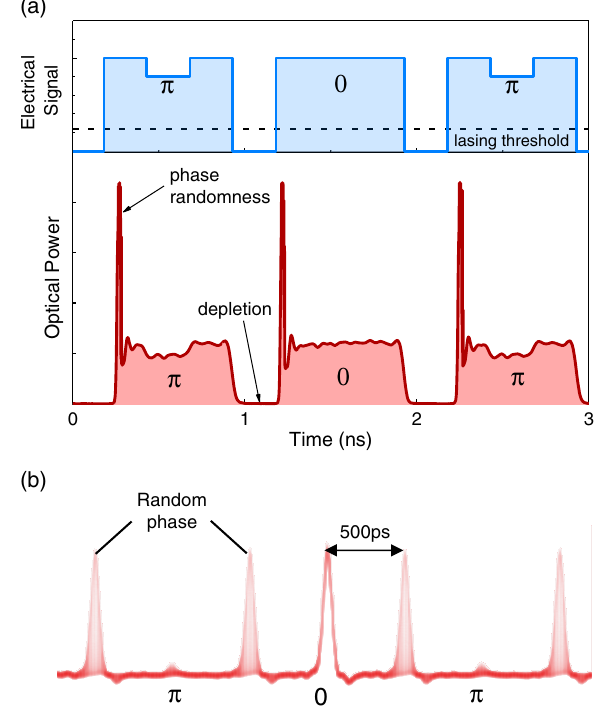
FIG. 3. Phase randomization pattern, adopted to guarantee security in the BB84 [13] and RR-DPS [33] protocol. We realize it here by depleting the cavity photon field in the phase- preparation laser prior between emission periods. (a) Upper panel: Driving signal applied to the phase-preparation laser. Lower panel: Temporal emission profile of the phase-preparation laser. (b) Color-coded density plot of the measured waveform of short pulses seeded by the injected light with the pattern shown in (a). The output with well-defined (random) intensity corresponds to the interference of short pulses seeded by the same (different) seeding